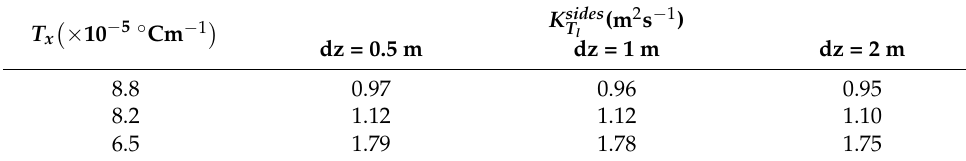
Table 2. The lateral diffusivities using different T x and dz.